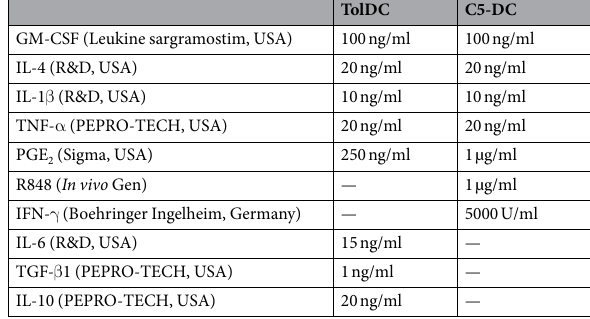
Table 2. Maturation cocktail for generation of tolDC and